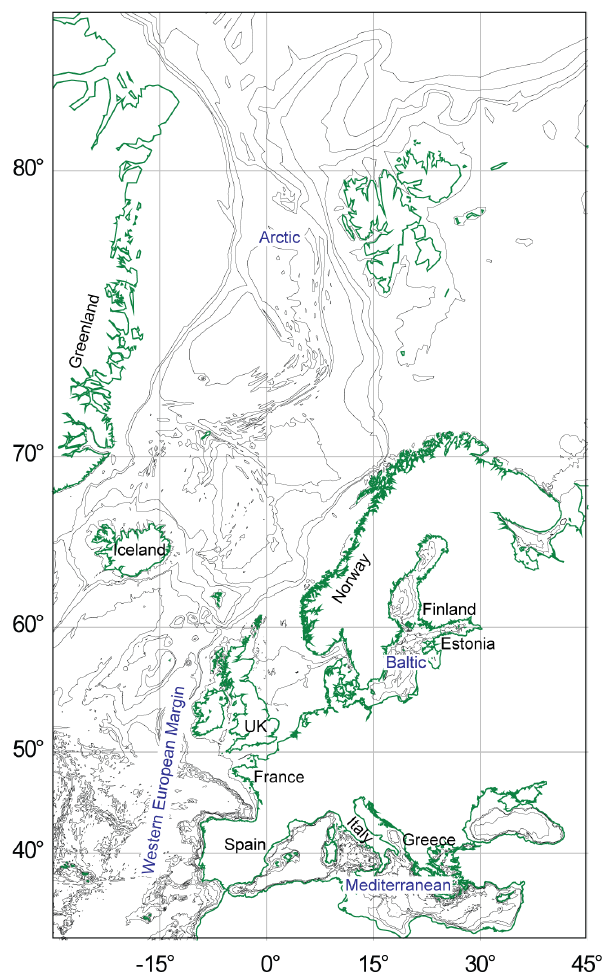
Figure 1. The major European Regional Seas.